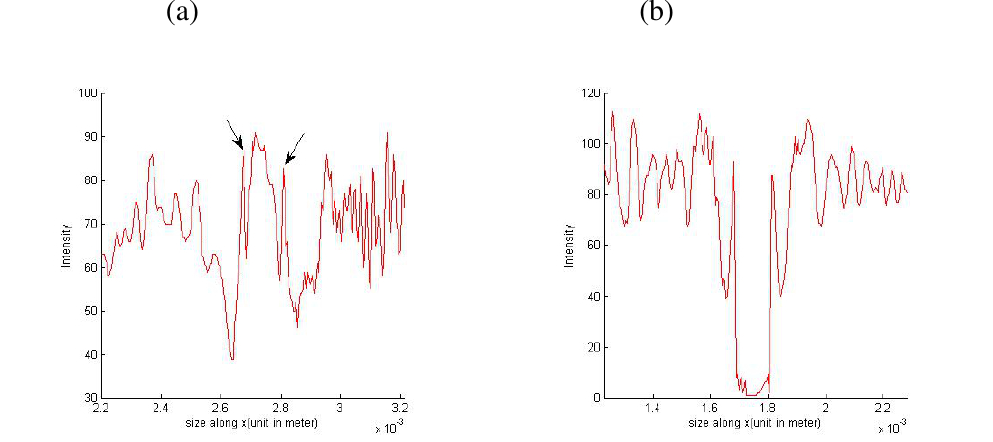
Figure 5. Transverse intensity profile of the reconstructed phase ( a ) and opaque ( b ) object: [ I ( x, y )]( x , y ) | . | F α α α opt x ,α opt y